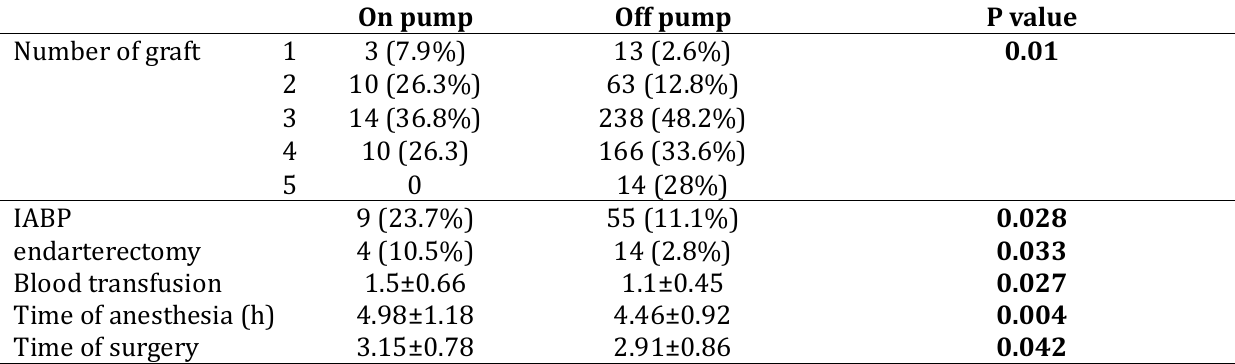
Table 3: intra-operative characteristics